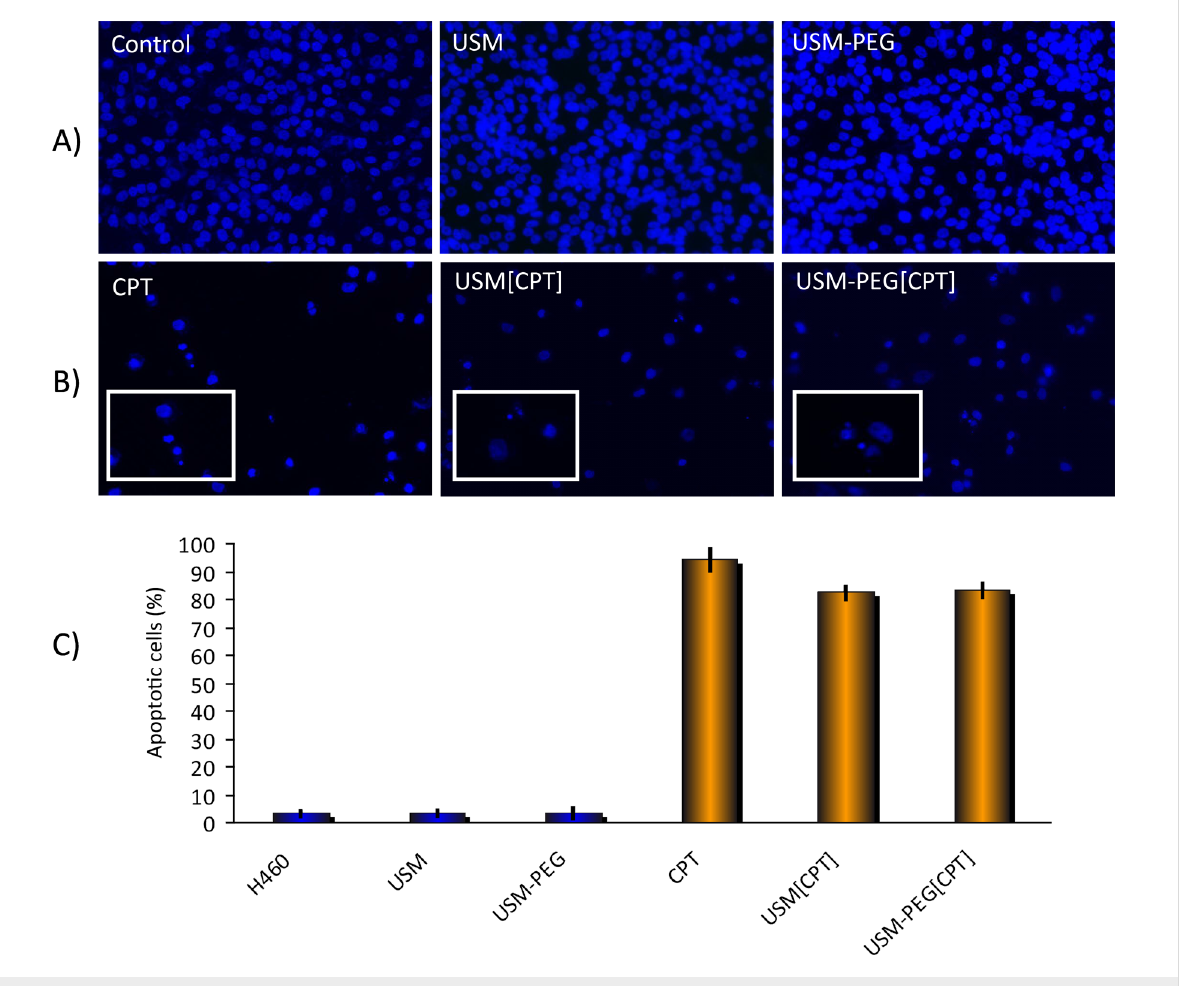
Figure 7: A: Fluorescence microscopy images of H460 cell cultures: control (left); with bare USM (middle); with PEGylated USM (right). B: Fluores- cence microscopy images of the H460 cell culture loaded with: CPT (left); USM[CPT] formulation (middle); USM-PEG[CPT] formulation (right) and details of apoptotic nuclei (inserted). C: Percentage of apoptotic cell nuclei in H460 cell cultures: From left to right, control, with bare USM, with PEG- ylated USM, with CPT, with USM[CPT], USM-PEG[CPT]. Stock dispersions of USM[CPT] and USM-PEG[CPT] were prepared in PBS (pH 7.5) with a CPT concentration of 5 mM, and 1 µL of this dispersion was added to H460 cells previously cultured (confluent; 1mL final volume, 5 μ M final CPT concentration). Cells with nanoparticles and references were incubated at 37 °C for 48 h. More than 100 cells were examined for each experimental condition. P < 0.05 significant differences with respect to control